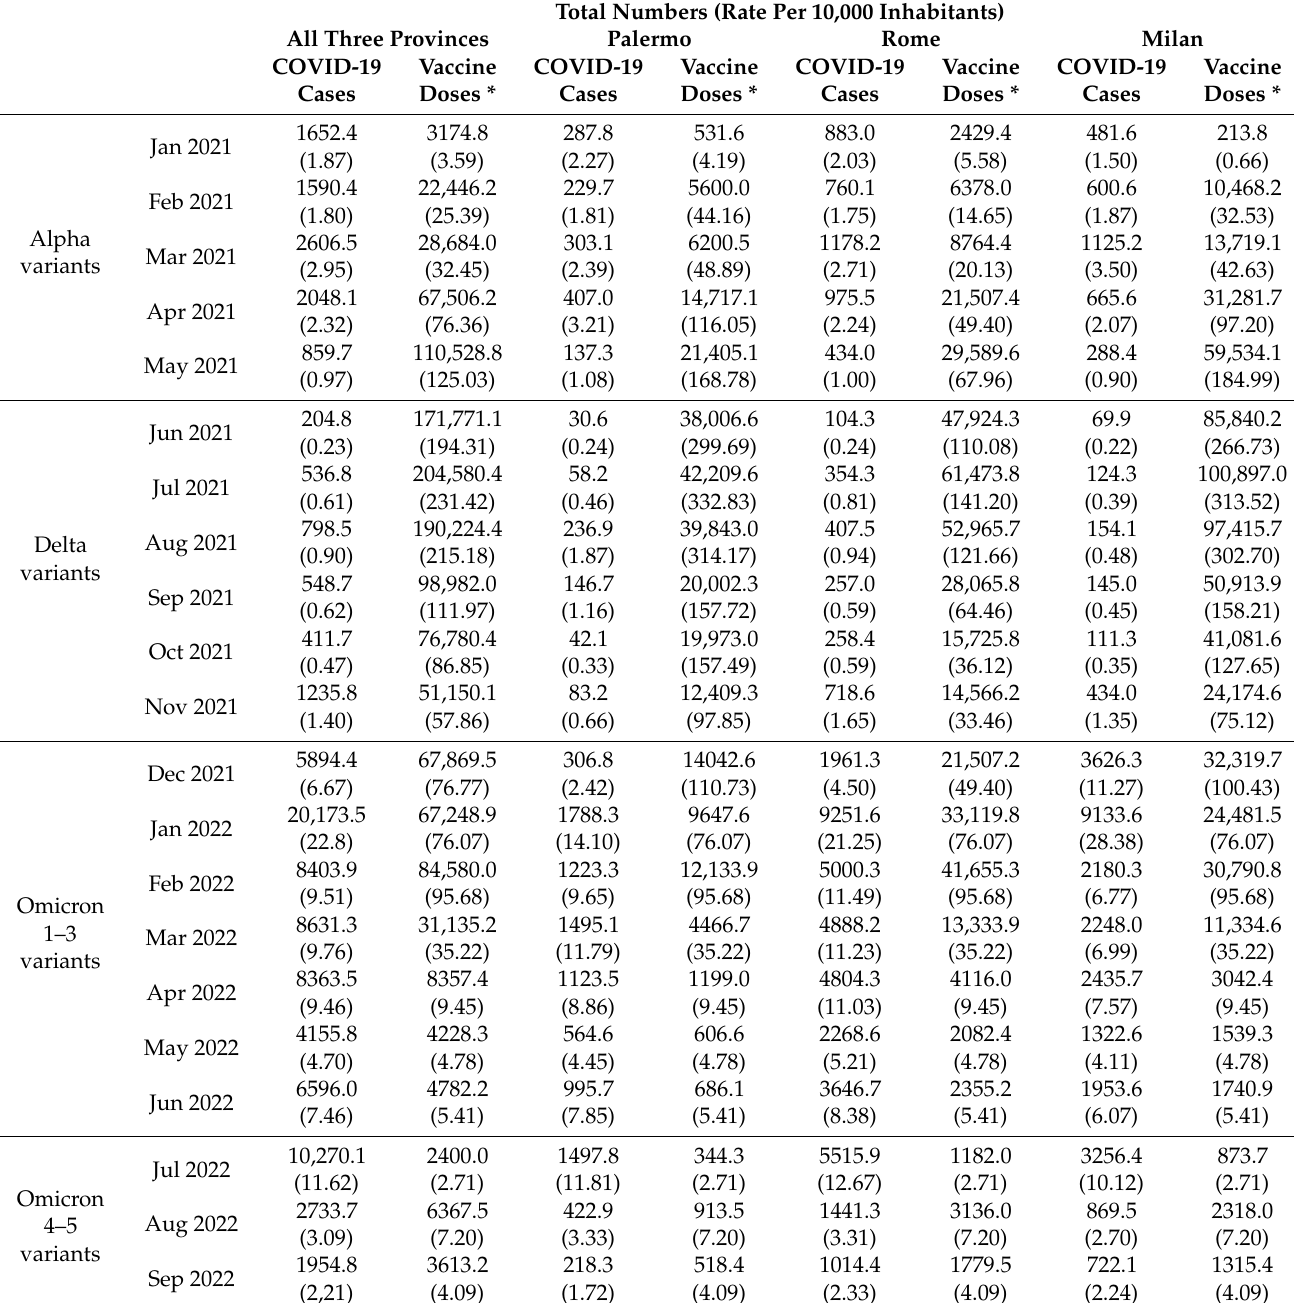
Table 1. Average daily COVID-19 cases and vaccine doses administered per month in Palermo,